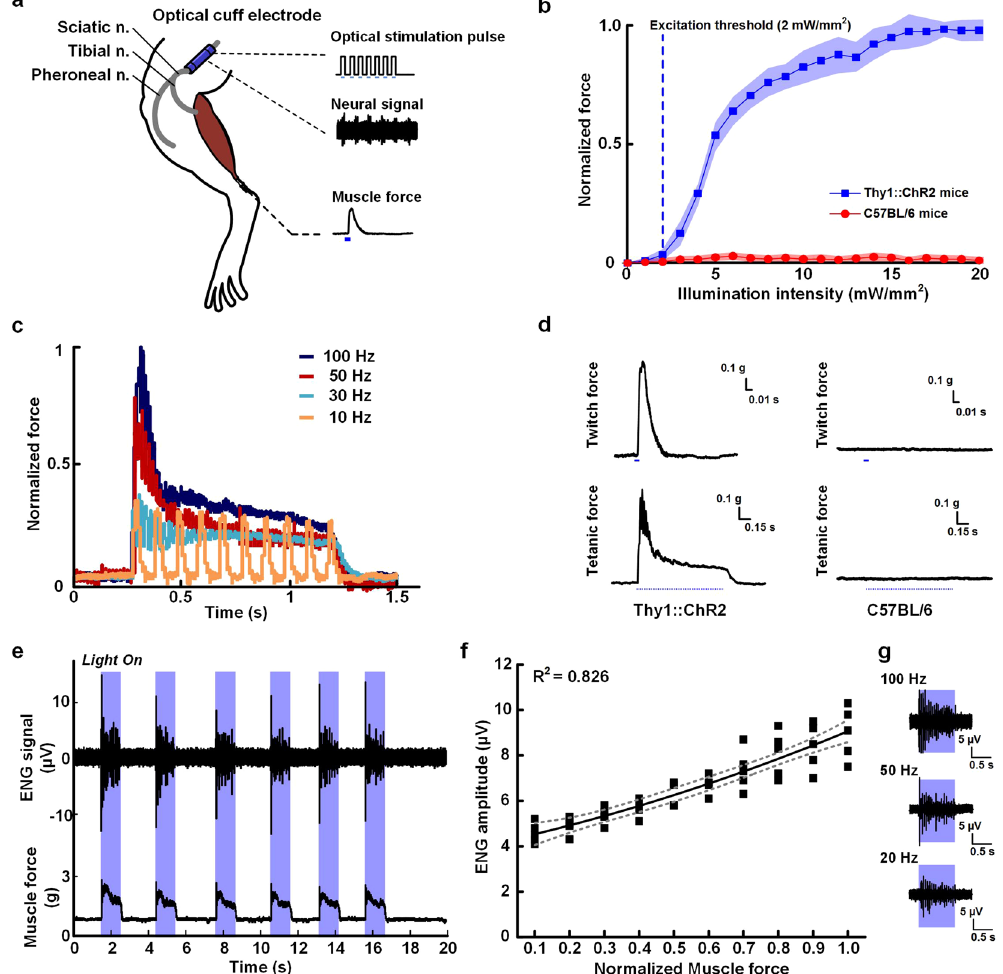
Figure 4. Optical controls of the simultaneous neural activity monitoring and optogenetic stimulation of the sciatic nerve of mice. ( a ) Schematic overview of the experimental setup for the optical control and neural activity monitoring of anesthetized mice. ( b ) Muscle force measurements during the optogenetic stimulation of Thy1::ChR2 and C57BL/6 mice. ( c ) Muscle force measurements with different stimulation frequencies (10 Hz, 30 Hz, 50 Hz and 100 Hz). ( d ) Typical force traces from the twitch and tetanic movements elicited by the optical stimulation. ( e ) Simultaneous neural activity monitoring during the optogenetic stimulation. The blue bars indicate the optical stimulation periods. ( f ) Correlation between the normalized muscle force and the neural signal amplitude. The correlation coefficient is R 2 = 0.826. The gray dashed line indicates the 95% confidence interval. ( g ) Neural signal recording at different stimulation frequencies (20, 50, and 100 Hz). The blue bars indicate the optical stimulation